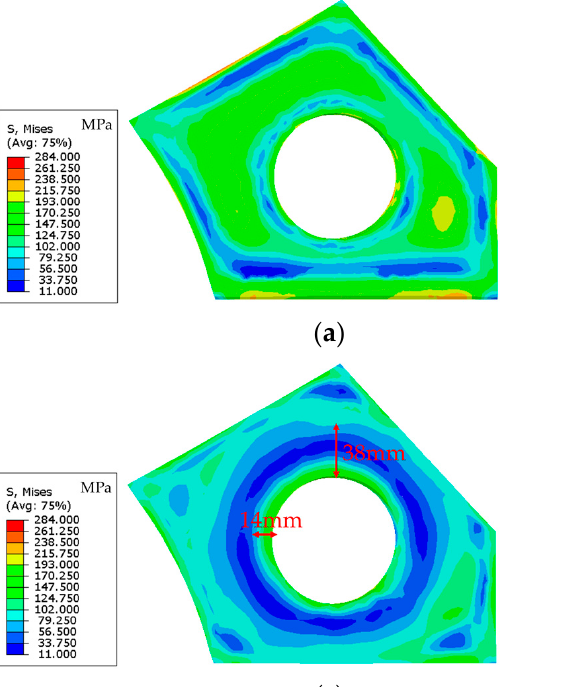
Figure 7. Stress contour diagram of the curved frame forging after quenching and cold expansion: ( a ) von Mises stress in the center thickness of the forging after quenching; ( b ) von Mises stress on the surface of the forging after quenching; ( c ) von Mises stress in the center thickness of the forging after cold expansion; ( d ) von Mises stress on the surface of the forging after cold expansion.